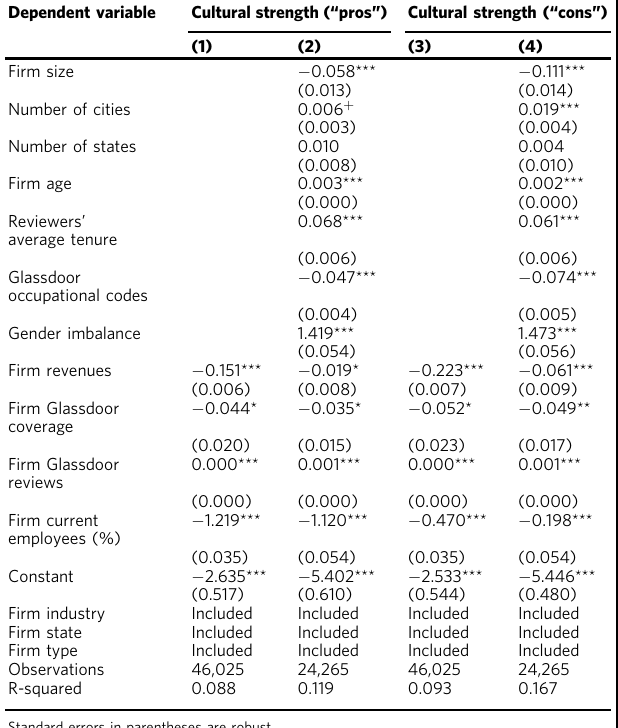
Table 3 Linear regression analysis of the relationship between Cultural strength and the covariates of interest: multivariate